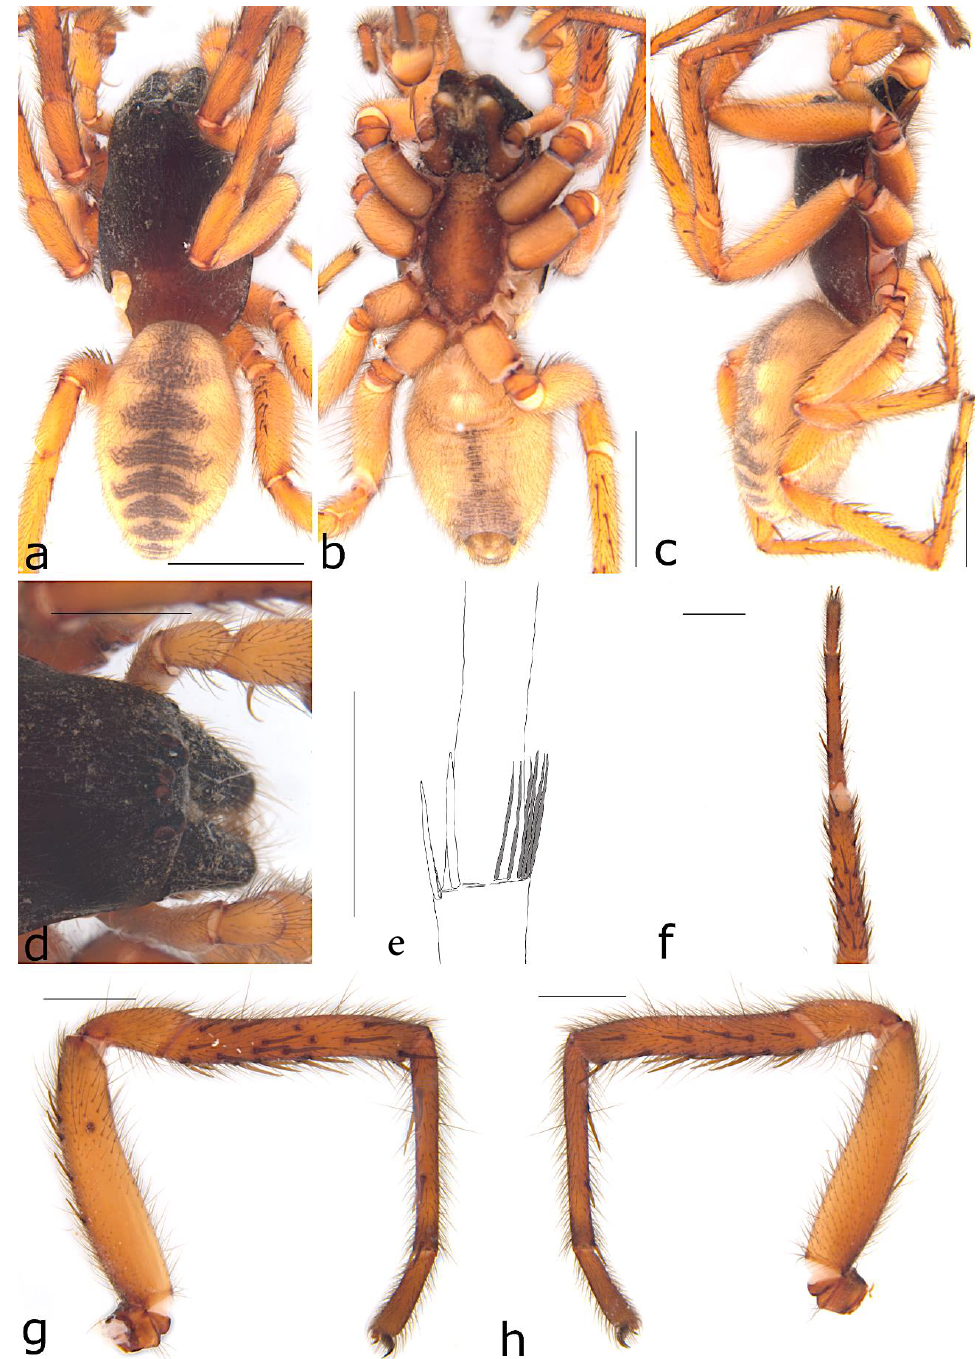
Figure 9. Ariadna spinosa sp. nov. ♂ holotype (SAMA NN22461) from Apoinga (SA): ( a ) habitus, dorsal view; ( b ) same, ventral view; ( c ) same, lateral view; ( d ) eyes, dorsal view; ( e ) left metatarsus IV, preening comb, retrolateral view, macrosetae of comb coloured grey for clarity; ( f ) left leg I, ventral view; ( g ) same, prolateral view; and ( h ) same, retrolateral view. Scale bars ( a – c ) = 2mm, ( d ) = 1 mm, ( e ) = 0.5 mm and ( f – h ) = 1 mm.